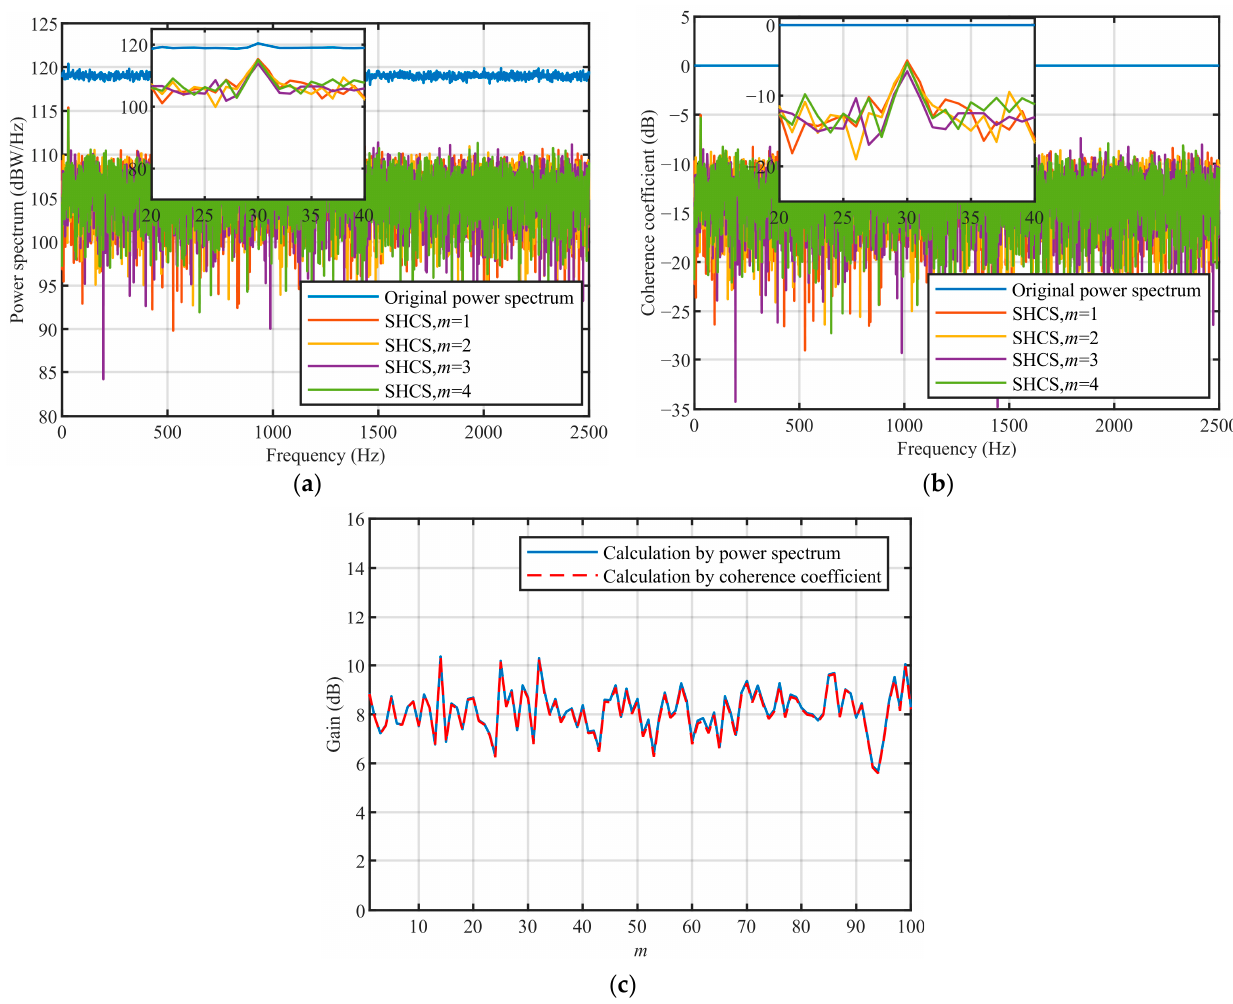
Figure 3. SHCS processing results with input SNR = 1 dB: ( a ) power ‐ spectrum estimation; ( b ) coherence ‐ coefficient calculation results; ( c ) gain.